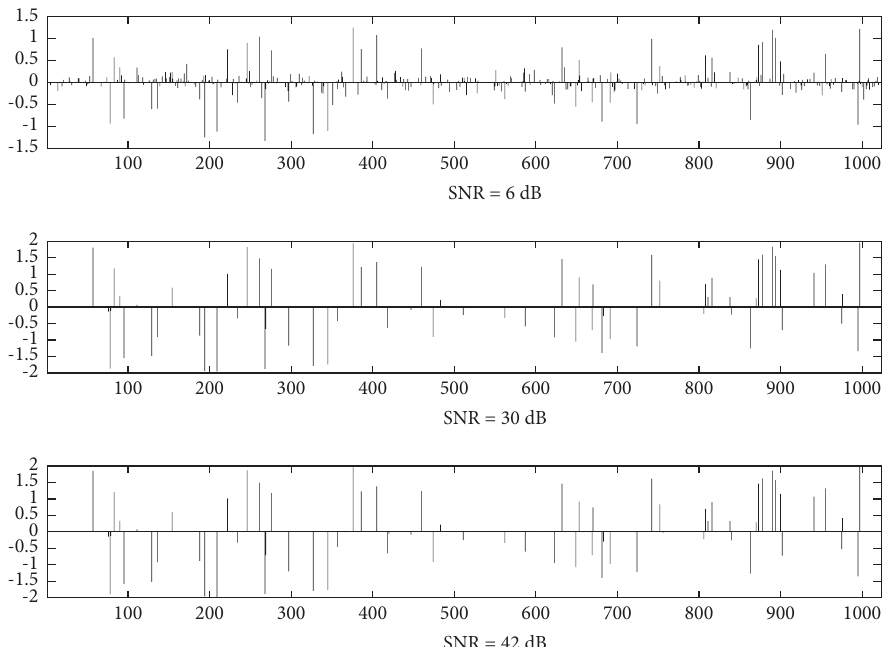
Figure 14: Recovering signals based on the SNR quality for the degraded signal with operator A